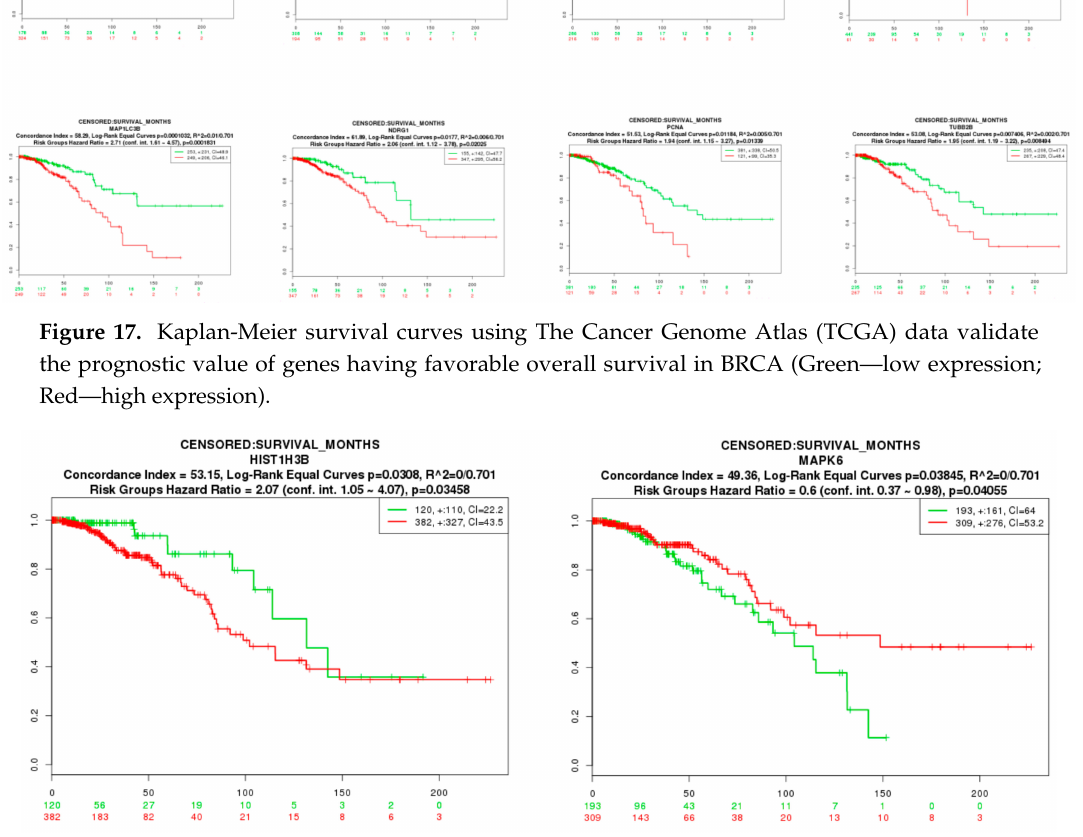
Figure 18. Kaplan-Meier survival curves using The Cancer Genome Atlas (TCGA) data validate the prognostic value of genes having worse overall survival in BRCA (Green—low expression; Red—high